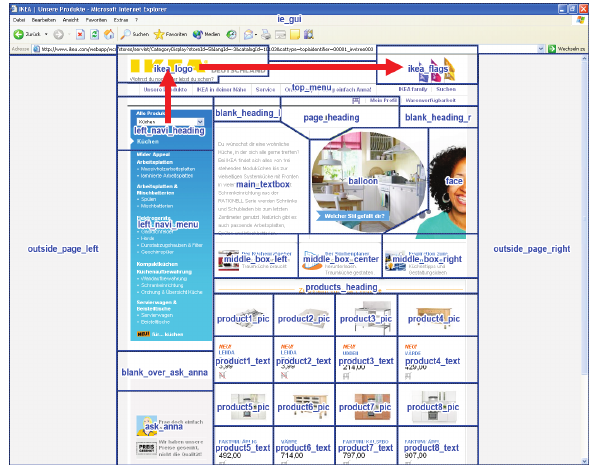
Figure 13. Unique IKEA pattern involving 1 varying and 2 fixed ROIs, occurring in 5 out of 10 presentations, initially in presentation 1 (participant 16)